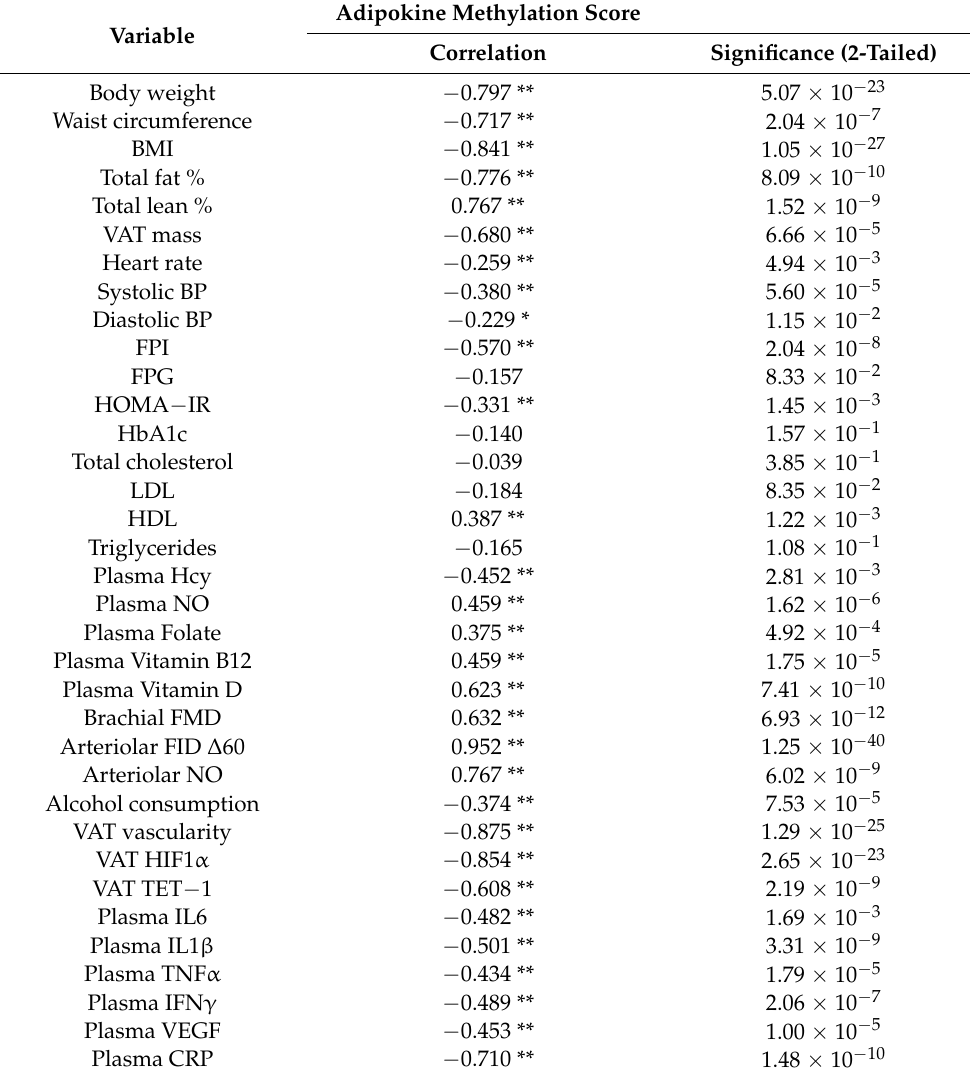
Table 5. Correlations between adipokine methylation score and cardiometabolic risk